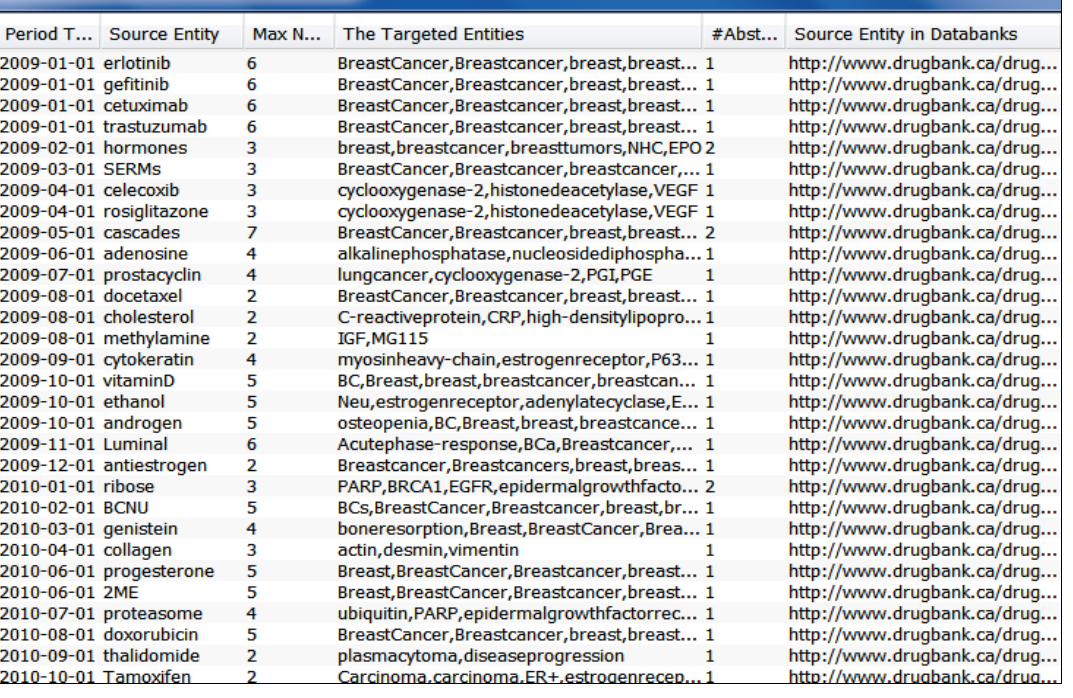
Figure 14. Annotation of highly targeted drugs linked to “Breast Cancer” from 2009/01 to